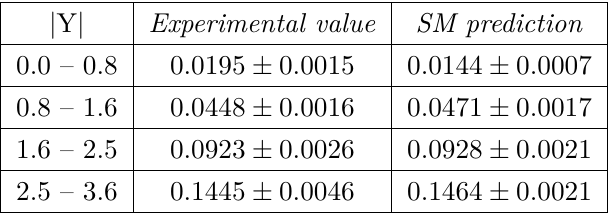
Table 3 . ATLAS A 4 measurements obtained in ref. [46] using invariant mass in the range ( 80 GeV , 100 GeV ). The SM predictions, obtained at NNLO in QCD, are also taken from ref.